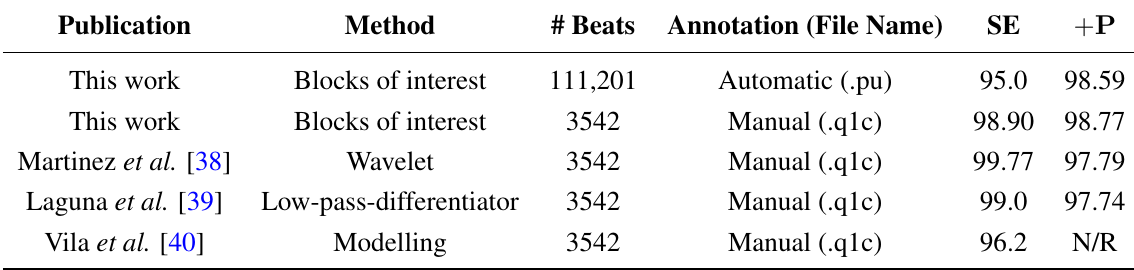
Table 4. T waves detection performance comparison on the QT database [24]. (N/R: not